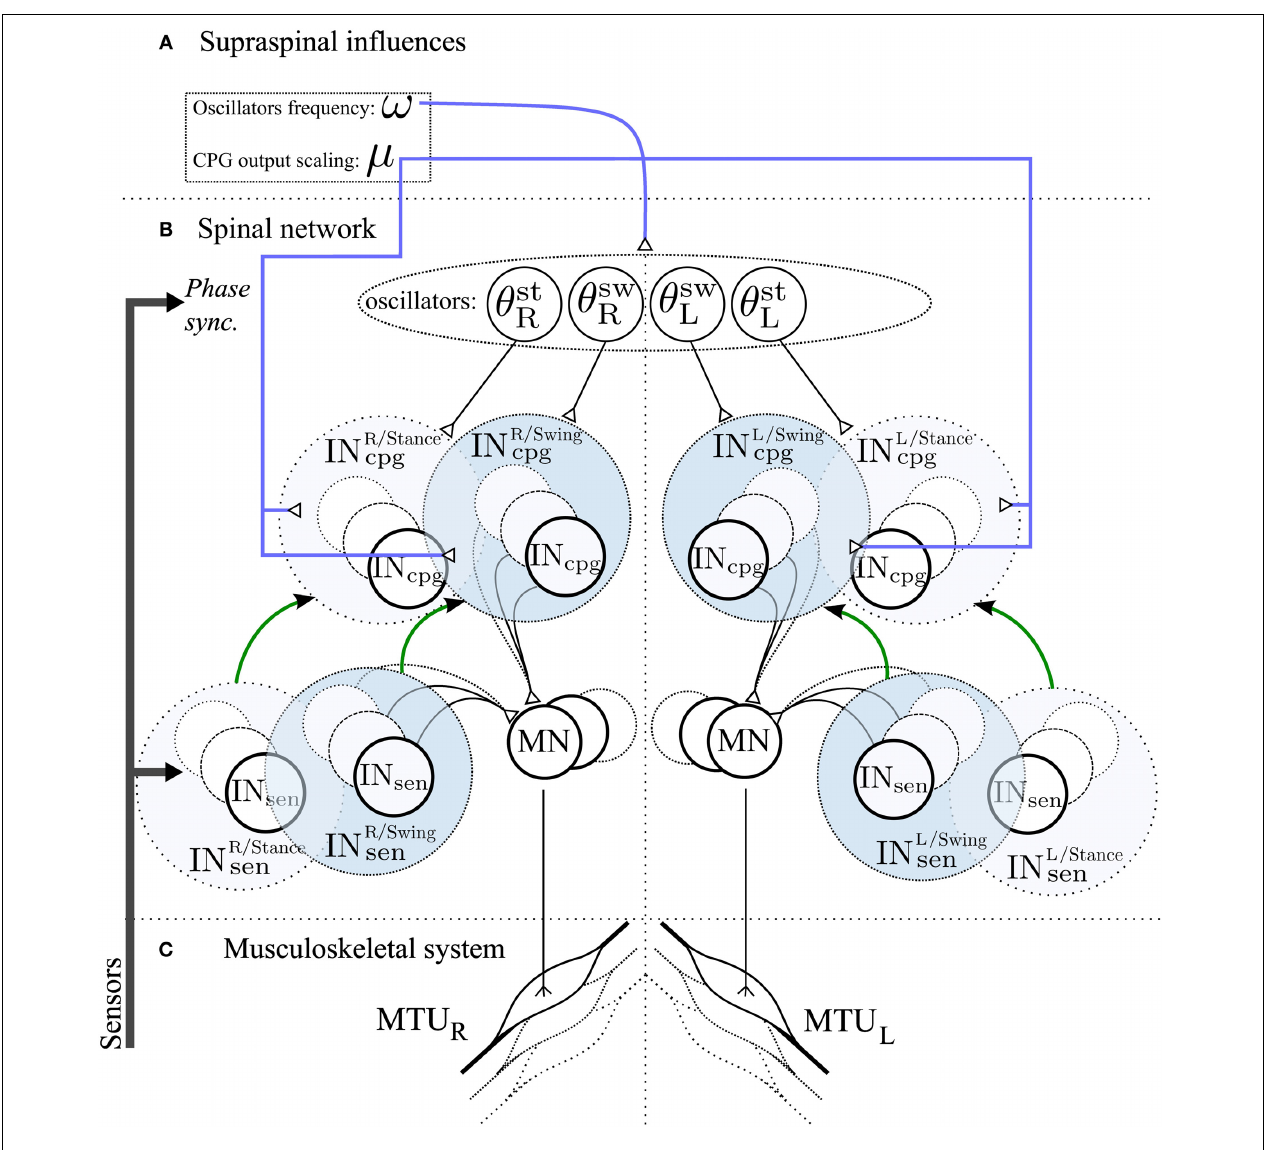
FIGURE 3 | Schematic representation of the spinal network and supraspinal control of the CPG network in the 3FBL model. The network is symmetric: left/right part of the figure corresponds to the part of the network acting on right/left limb muscles respectively. (A) Suprasinal influences: μ represents the activity modulation pathway and ω the frequency of the CPG network. All 4 oscillators share the same ω , but each CPG can have a different μ . If not stated otherwise, all IN osc cpg and IN cst cpg share the same amplitude modulation μ osc and μ cst , respectively. (B) Spinal